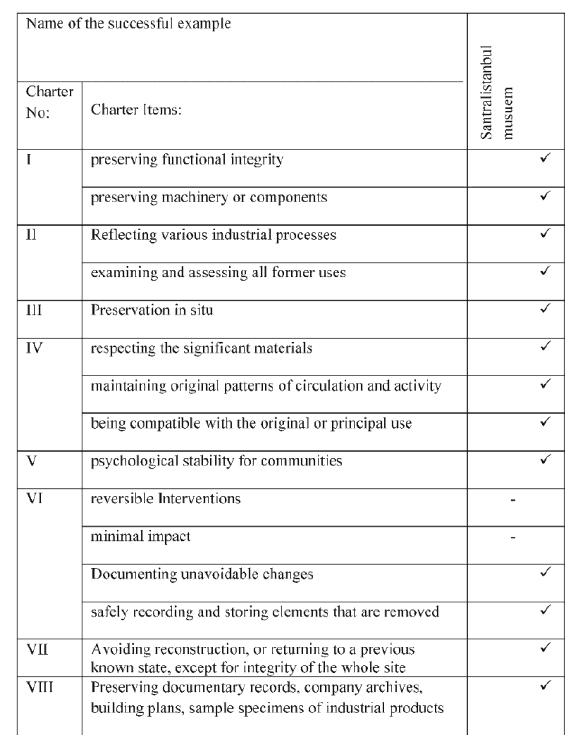
Table 3. The degree of success in reusing of energy museum Based on Nizhny-Tagil Charter (AKSOY, 2007).